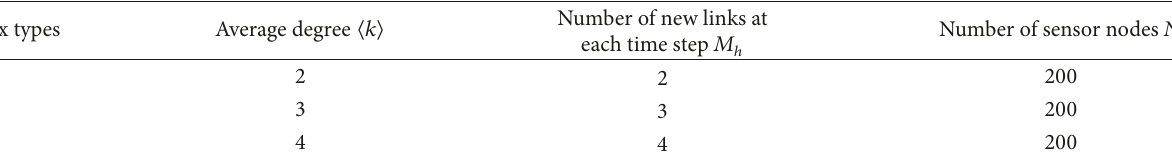
Table 2: Types of matrix 𝐴 for homogeneous scale-free network and heterogeneous scale-free network.